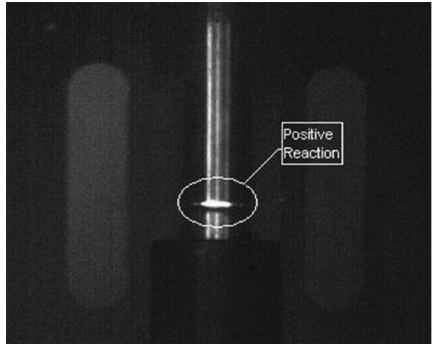
Figure 5: Visible signs of reaction [9].